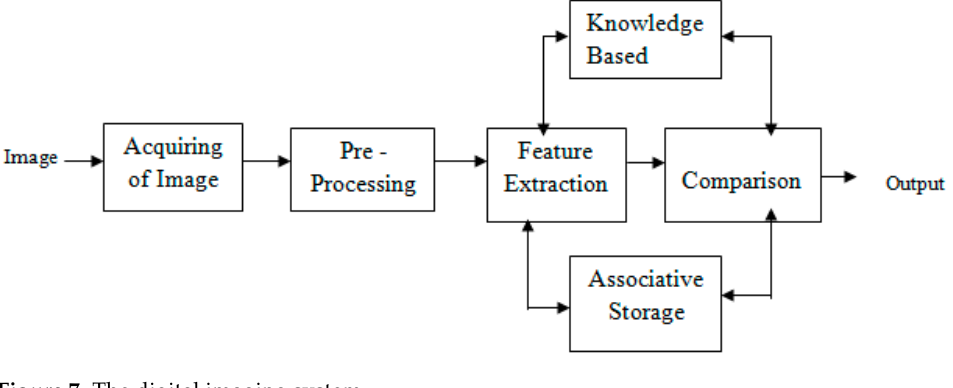
Figure 7. The digital imaging